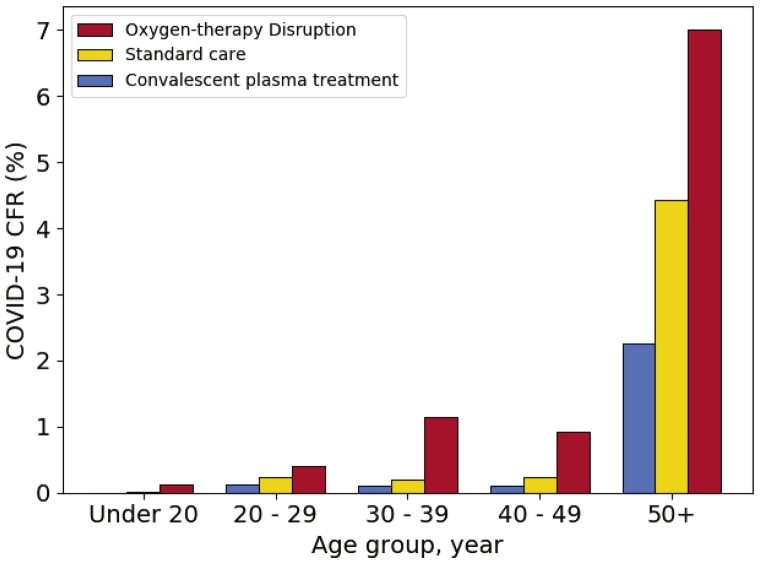
Differential mortality rates modeled as results of convalescent plasma and oxygen therapy effect sizes.